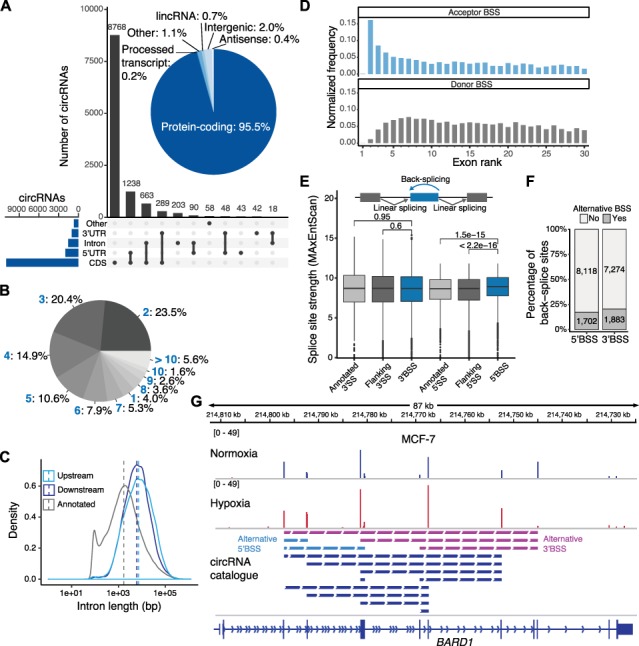
Genomic features of circRNAs. (A) circRNAs are mainly produced from CDS of PCGs. Bar chart displaying the frequency of transcript regions harboring the 5′ and 3′ back-splice sites that come together in a given circRNA. Inlay: pie chart showing the genomic origin of circRNAs. (B) Most circRNAs comprise < 5 putative internal exons. Pie chart showing the percentage of circRNAs with a given number of annotated exons (blue) located between the back-splice sites. (C) Back-splice sites are flanked by longer introns than average. Density plot showing distribution of intron lengths for circRNA-flanking introns (upstream and downstream) compared to all introns annotated in GENCODE version 24. Dashed lines indicate median. (D) Distribution of exon ranks involved in circRNA formation as acceptor (top) or donor splice site (bottom). The normalized frequency was obtained by dividing the frequency of a certain exon rank as acceptor/donor splice site by the number of genes containing at least this number of exons +1 (GENCODE version 24). Only circRNAs produced from PCGs and with both back-splice sites within the same annotated transcript were evaluated (n = 9676). (E) Strength of 5′ back-splice sites is significantly higher than at flanking 5′ linear splice sites and 2000 randomly selected 5′ linear splice sites (GENCODE version 24). Splice site strength estimated with MaxEntScan (Yeo and Burge, 2004). Same circRNA selection as in D, further excluding circRNAs involving first/last exons of annotated transcripts, resulting in 9664 circRNAs. (F) More than 20% of back-splice sites participate in alternative back-splice events. (G) Alternative 3′ (magenta) and 5′ (light blue) back-splicing generates 14 distinct circRNA isoforms from the BARD1 gene in A549, HeLa, and MCF-7 cells. Genome browser view of BARD1 gene, showing chimeric alignments (back-splice reads) from RNA-Seq of MCF-7 cells under normoxic and hypoxic conditions. Dashed lines below connect the paired back-splice sites. The BARD1 gene is located on the minus strand.